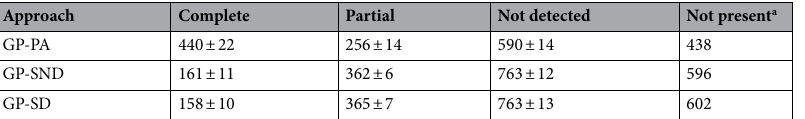
Table 1. Average number of strain specific Genome Property classes per approach. a Number of genome properties not presented in any of